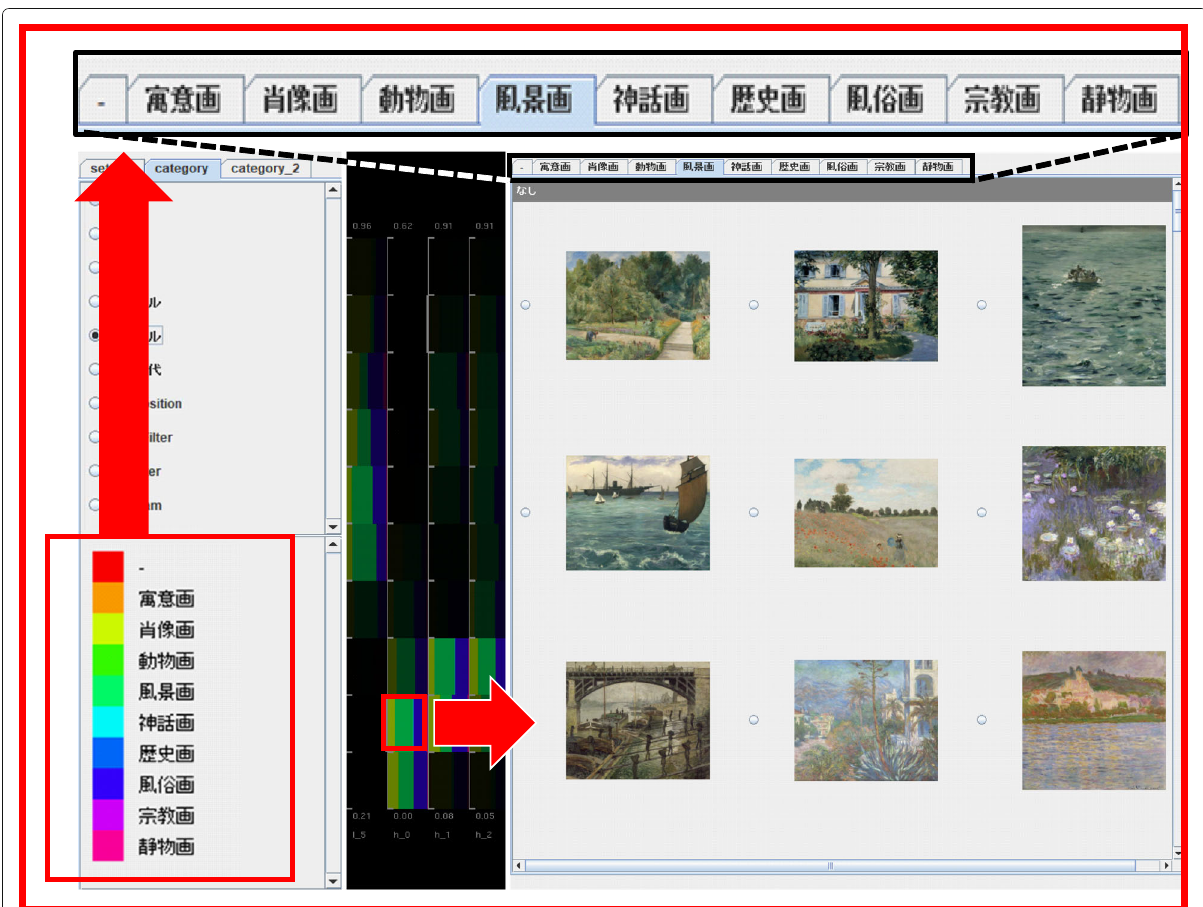
Fig. 4 Corresponding painting images are displayed according to the click operations of component bar charts